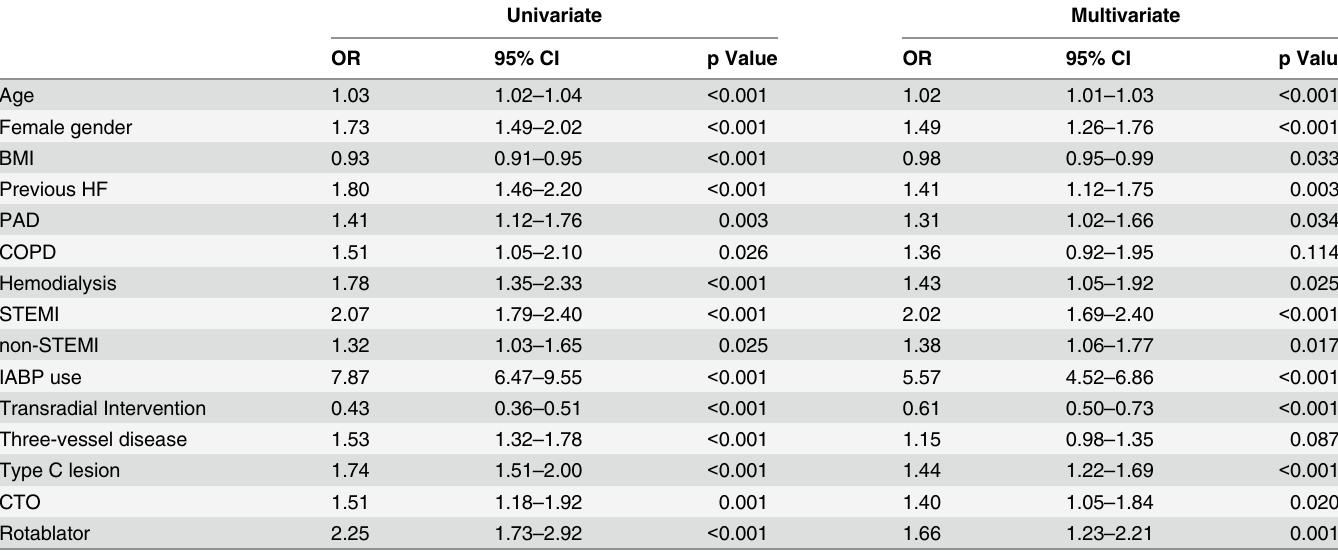
Table 7. Multivariate Logistic Regression Analysis on Overall Complications in Patients without Cardiogenic Shock.